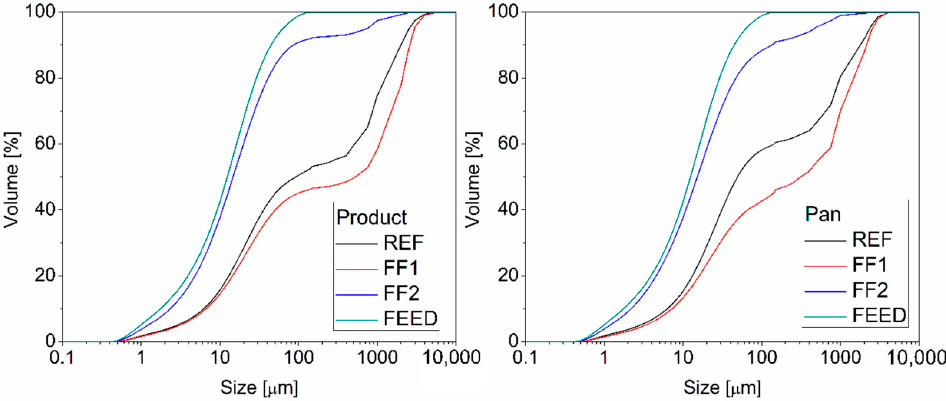
Figure 6. Influence of the feed flow on PSD of product and pan samples of the granulation.